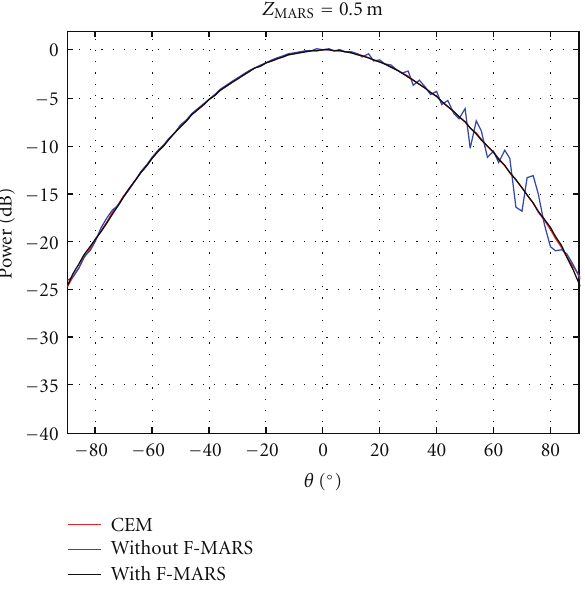
Figure 12: Far-field cut with and without MARS processing. Dis- placement of 50cm.